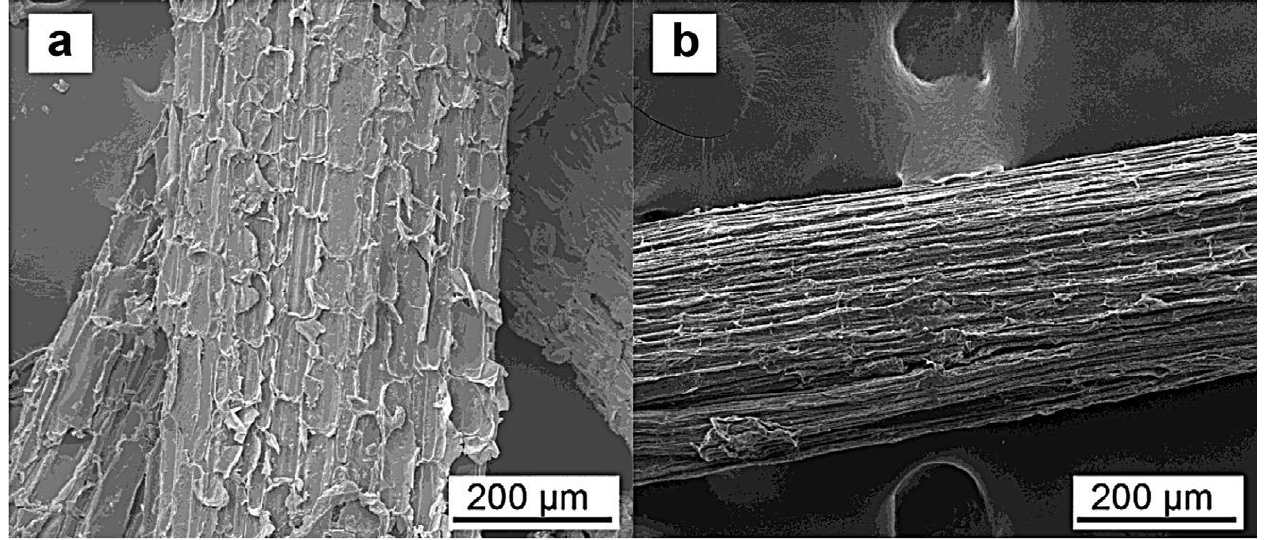
Figure 4. ( a )Untreated corn fiber; ( b ) Alkali treated fiber. Reprinted with permission from Ref. [111], copyright 2022, Elsevier.